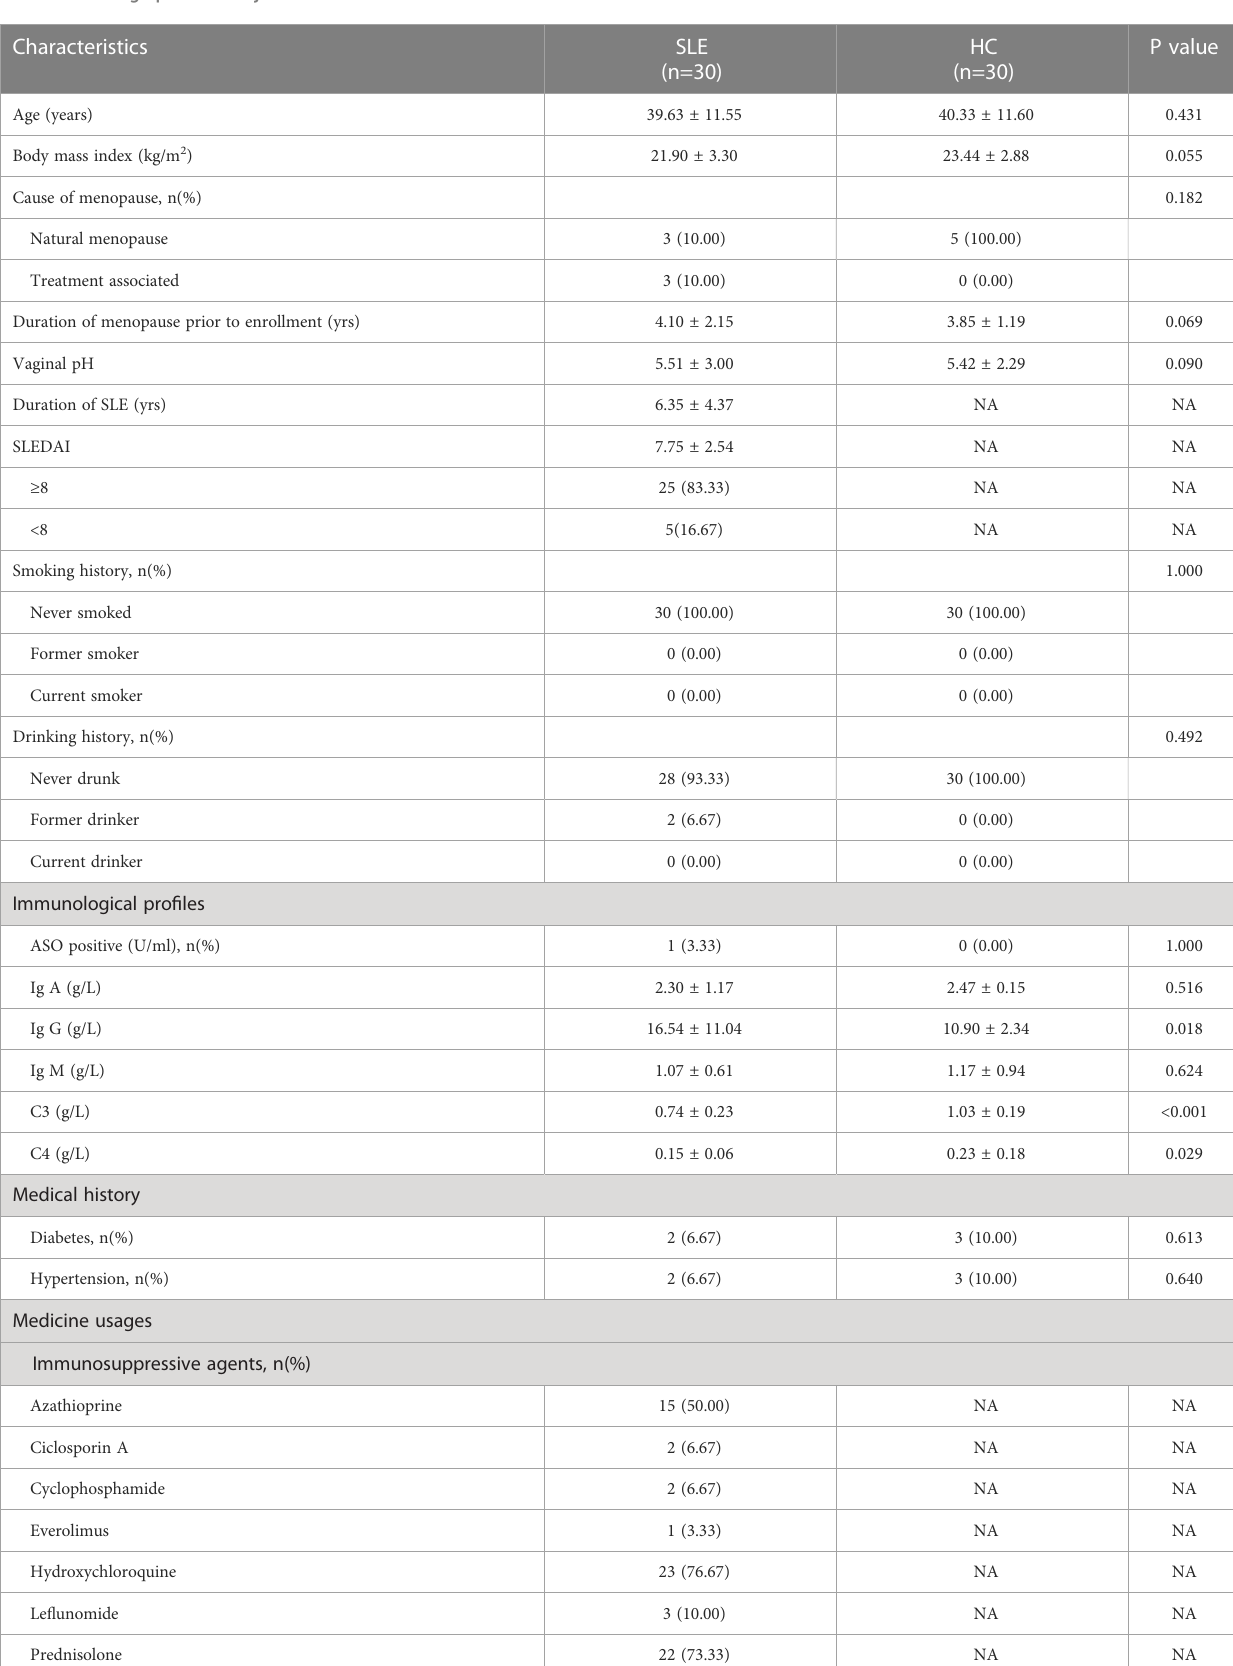
TABLE 1 Demographics of